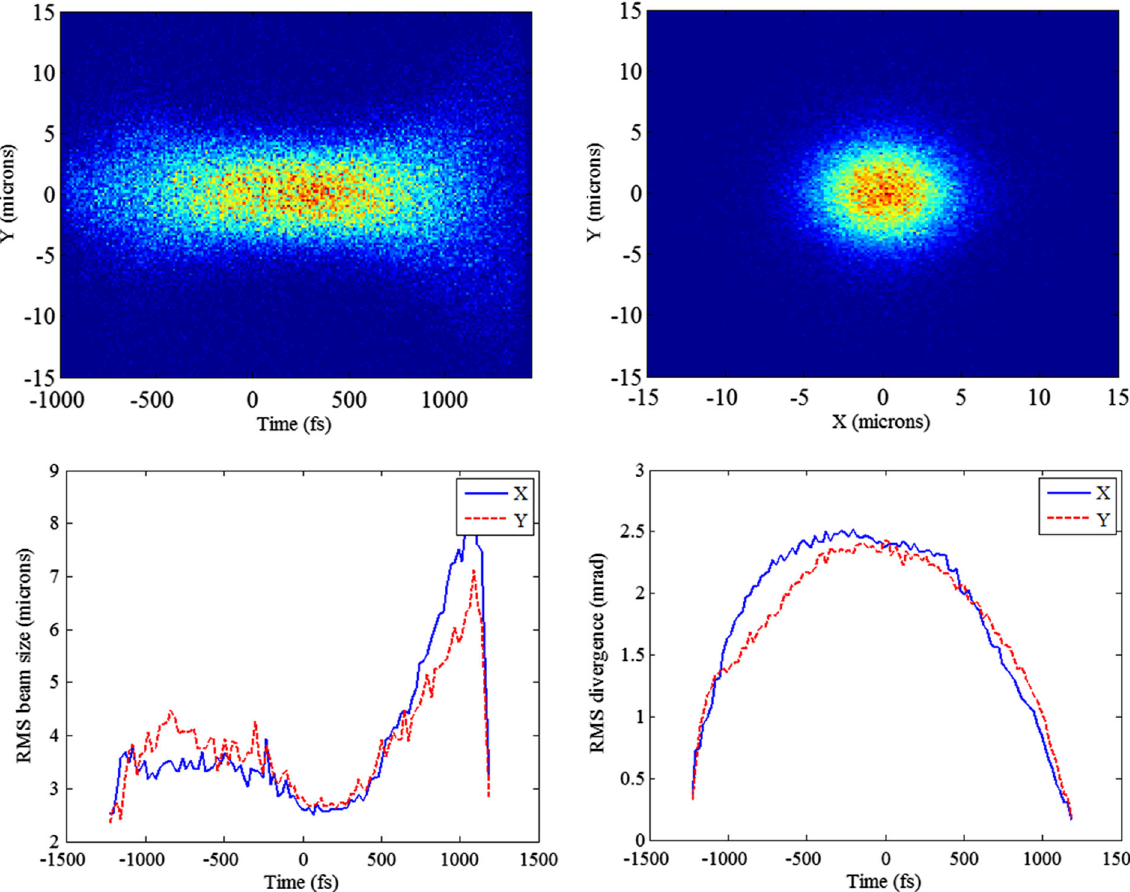
FIG. 12. Plots of transverse properties of electron beam at interaction point. The upper left shows the density plot of electron position vs time showing most of the beam is well focused. The upper right plot shows time-integrated beam intensity with rms spot size of 3 . 5 μ m. The lower left plot shows variation in focus size of different time slices and the lower right plot shows beam divergence vs time. The electron beam divergence of 2 – 3 mrad is similar in magnitude to the x-ray opening angle.